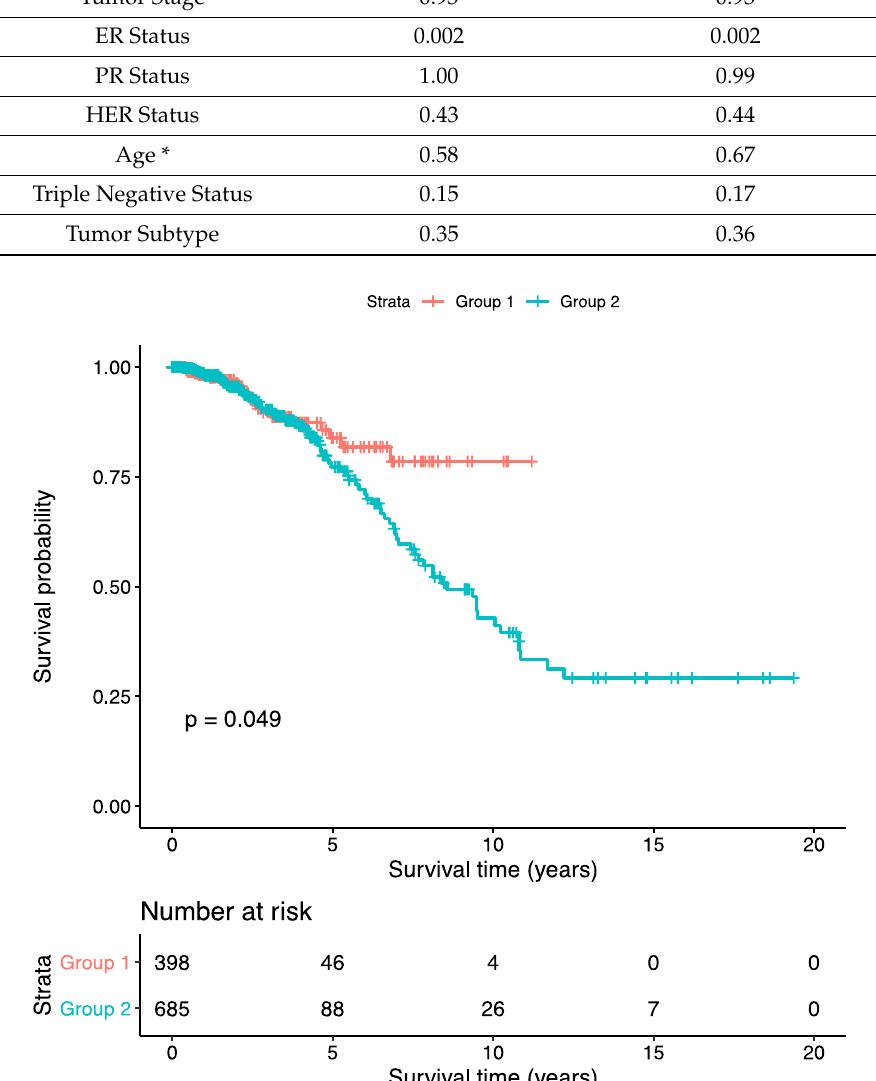
Table 3. Cox’s proportional hazards (COX-PH) results for risk scores. Risk Score